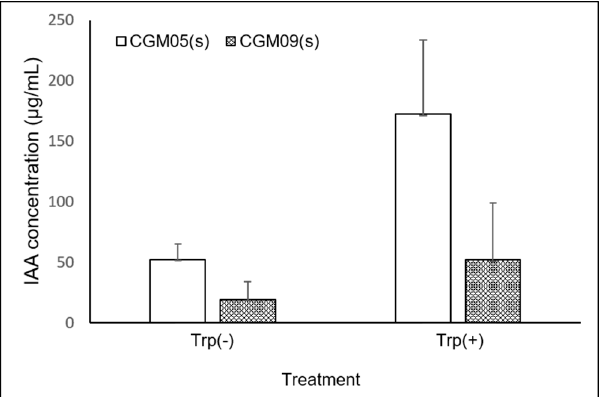
Figure 3. Comparison of IAA production by the bacterial isolate, CGM05, and CGM09, in LB medium with or without Trp. Mean of three independent experiments.